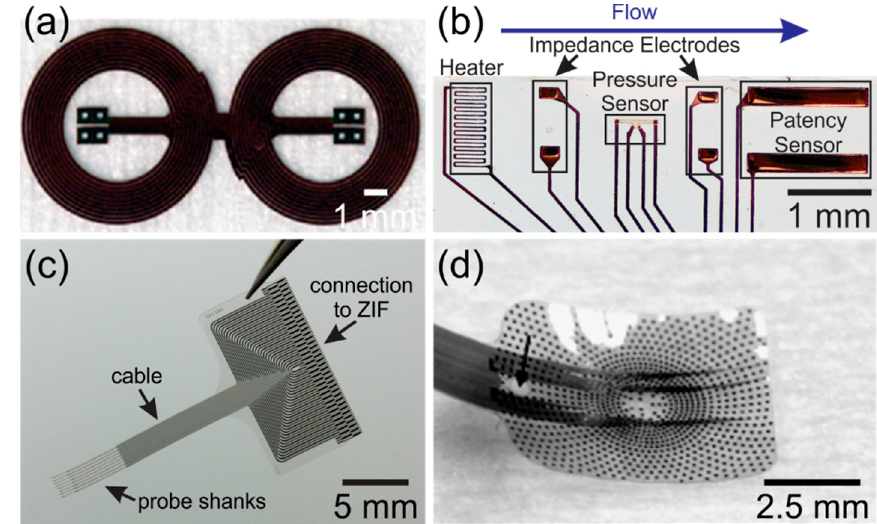
Figure 3. ( a ) Wireless coils (Reprinted from Reference [16] with permission from Elsevier); ( b )